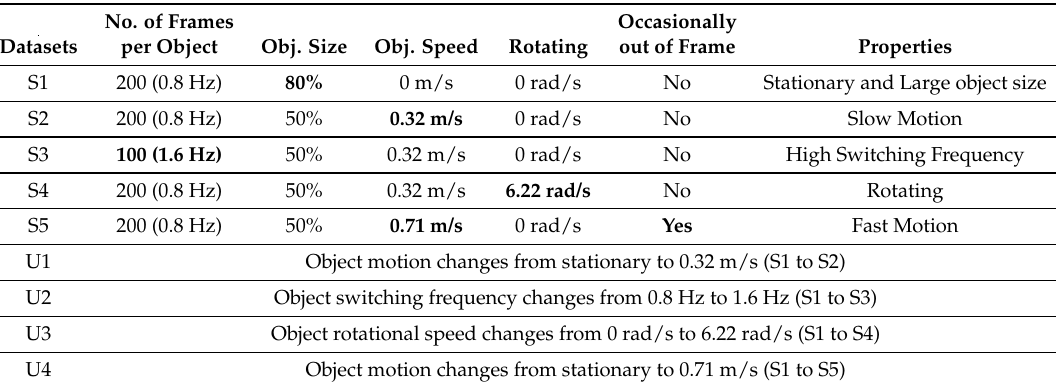
Figure 2. Experimental setup. Table 2. Details of self-generated